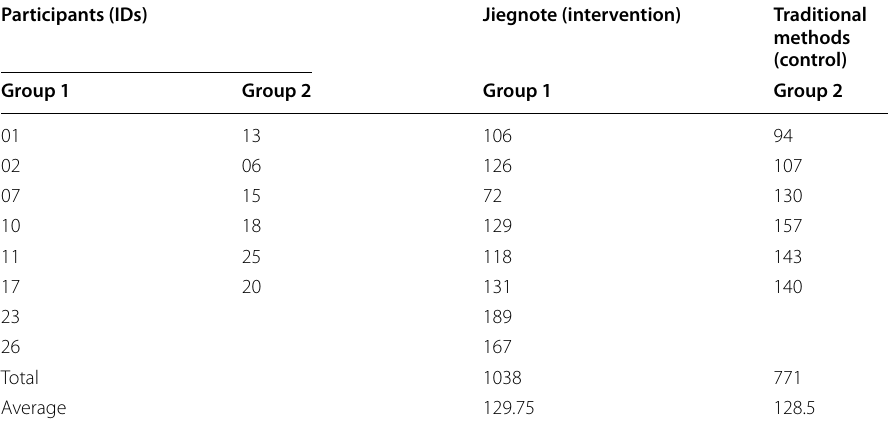
Table 4 Transcription errors committed during cases; C, and